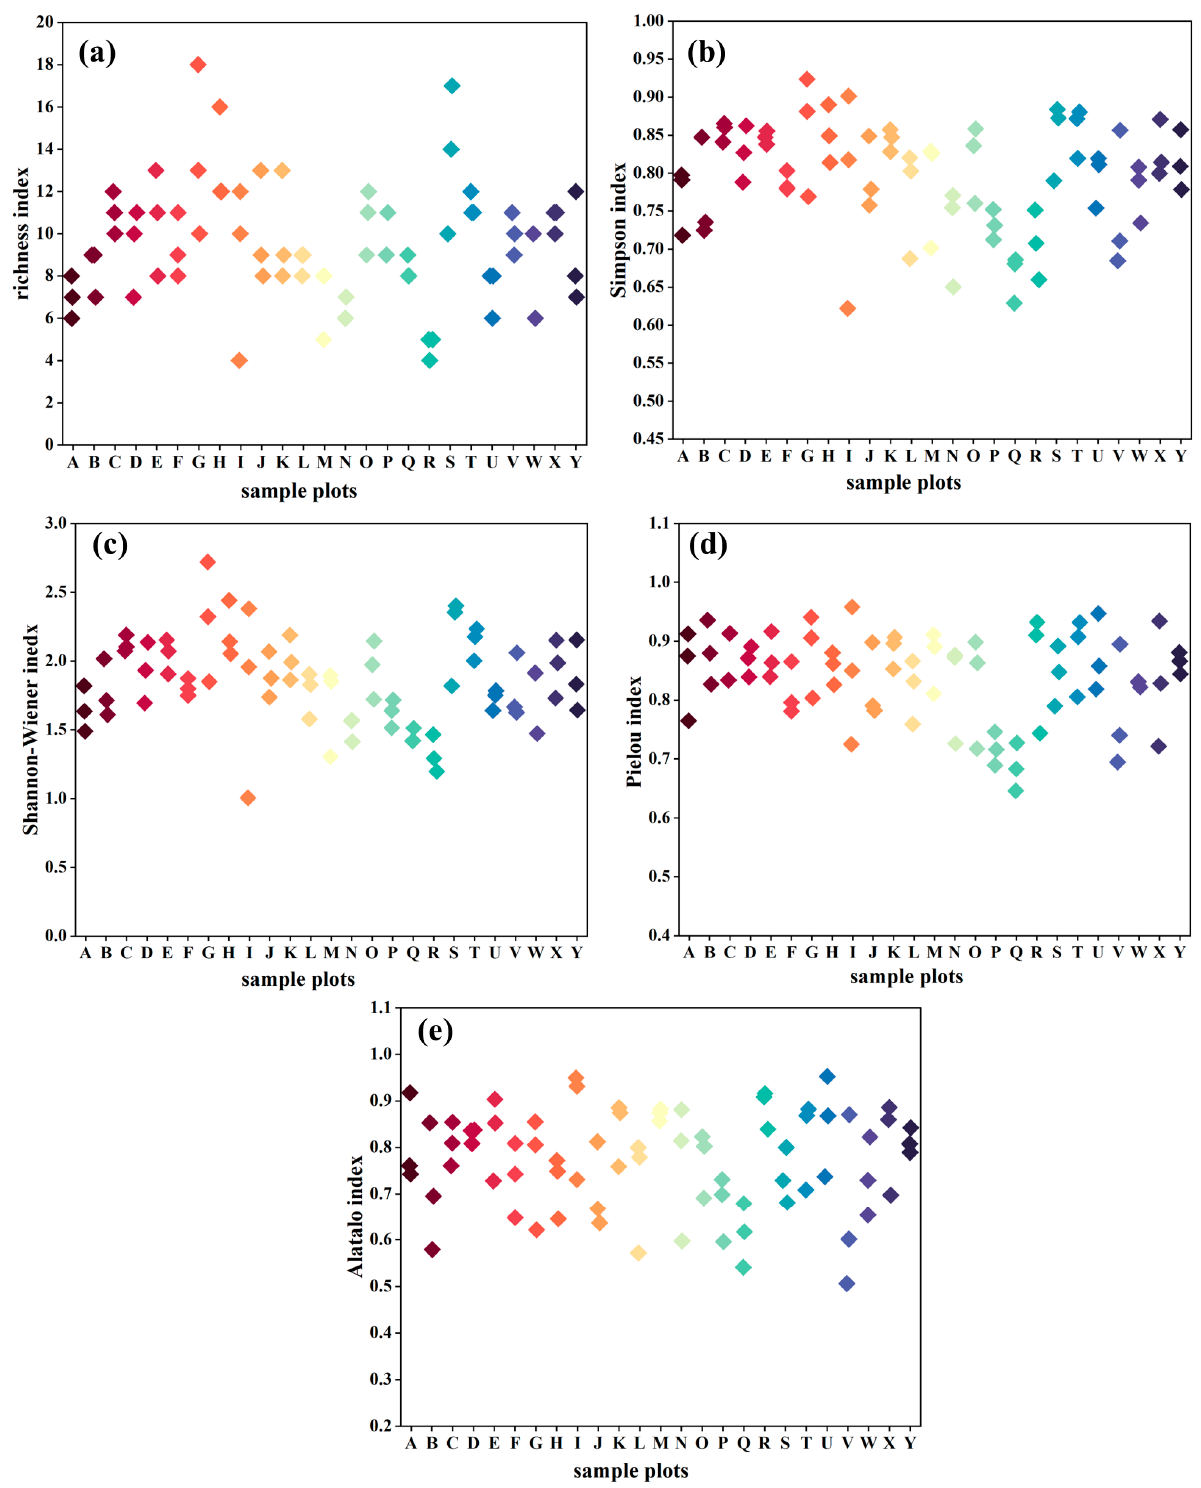
Figure 3. Distribution characteristics of species diversity in three quadrats of the sample plots. ( a ) Species richness index of three quadrats in sample plots; ( b ) Simpson index of three quadrats in sample plots; ( c ) Shannon–Wiener index of three quadrats in sample plots; ( d ) Pielou index of three quadrats in sample plots; ( e ) Alatalo index of three quadrats in sample plots.